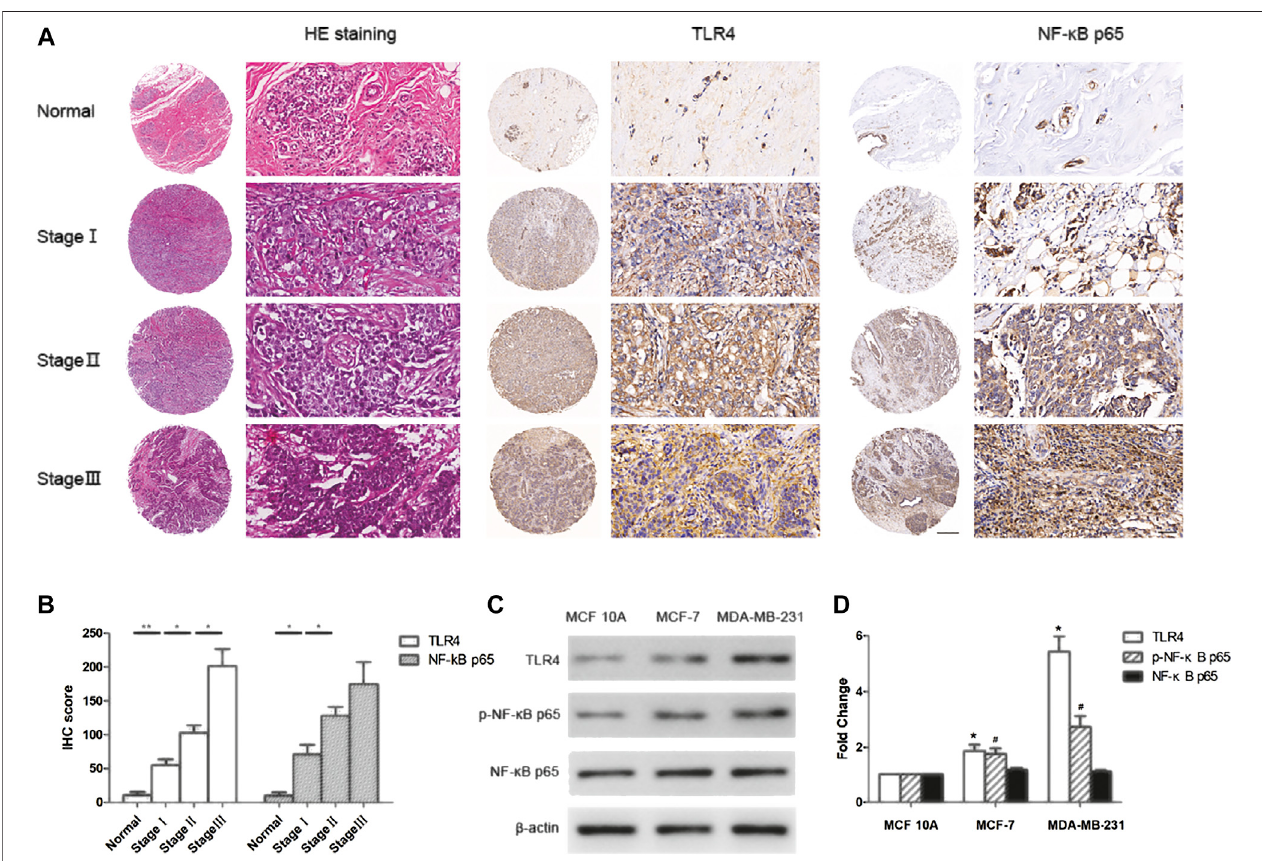
FIGURE 1 | TLR4 and NF- κ B were over expressed in breast cancer and correlated with TNM stages. (A, B) Representative immunohistochemistry staining for TLR4andNF- κ Bp65innormalbreasttissuesandbreastcancertissueswithdifferentTNMstages.* p < 0.05,** p < 0.01betweendifferentgroups. (C,D) Theexpression of TLR4, p-NF- κ B p65 and NF- κ B p65 in MCF 10A, MCF-7 and MDA-MB-231 cells by western blot. Signi fi cant differences between different groups were indicated as * p < 0.01, vs. MCF 10A group, n (cid:1)